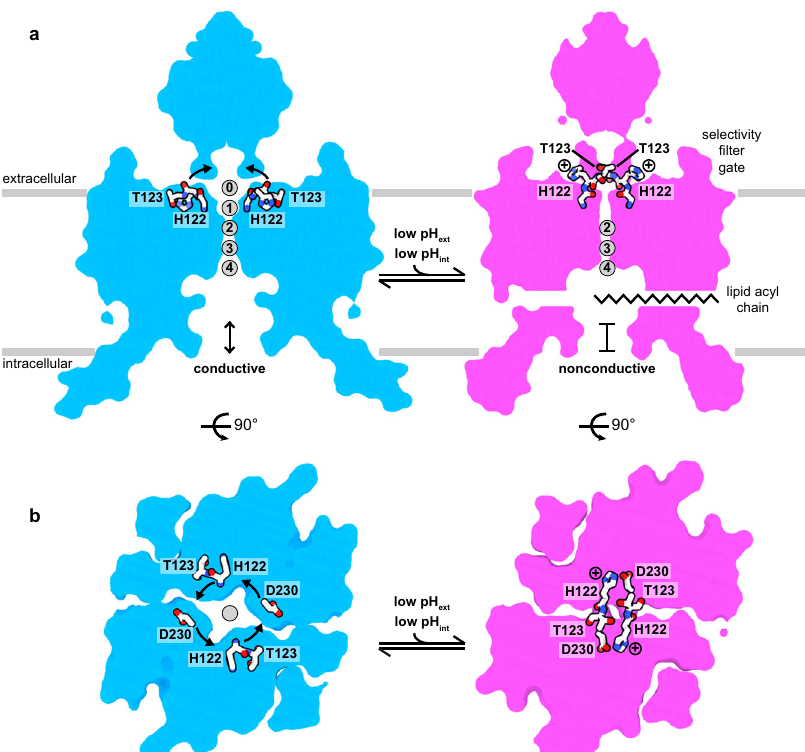
Fig. 5 Structural model for pH-gating of the TWIK1 channel. a , b Model for selectivity fi lter gating of TWIK1 gating by pH ext viewed from ( a ) the membrane plane and ( b ) the extracellular side. TWIK1 is conductive at a high pH. At low pH, H122 protonation results in conformational changes that disrupt K + coordination sites S0 and S1, seal the top of the selectivity fi lter, displace the helical cap to block extracellular ion access pathways, and dilate a lateral membrane opening to permit acyl chain binding to the channel